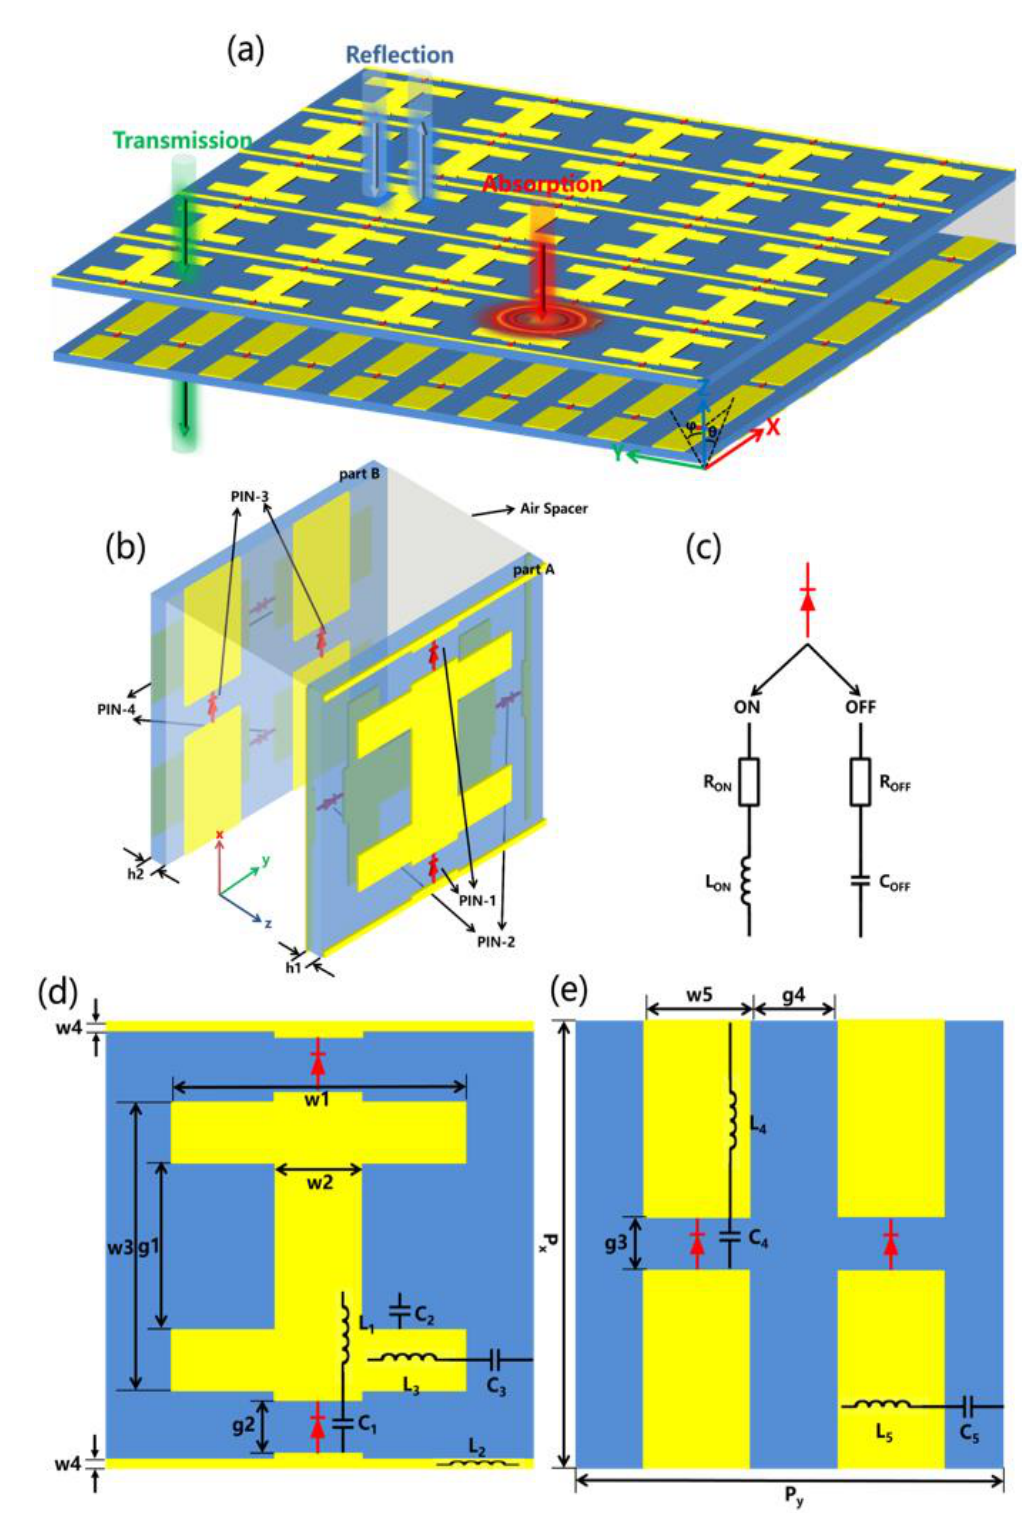
Figure 1. ( a ) The three-dimensional schematic of the proposed metadevice and illustration of EM functionalities; ( b ) Perspective view of the proposed meta-atom; ( c ) Equivalent circuit model of the PIN diode at the “on” and “off” states; ( d , e ) Top view of part A and part B.